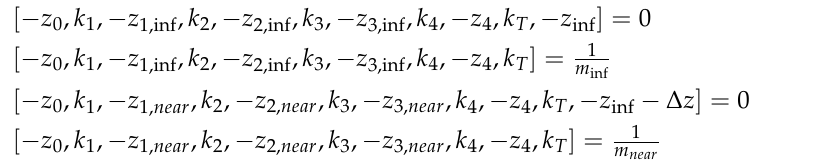
Figure 2. Paraxial optical layout for the third solution.